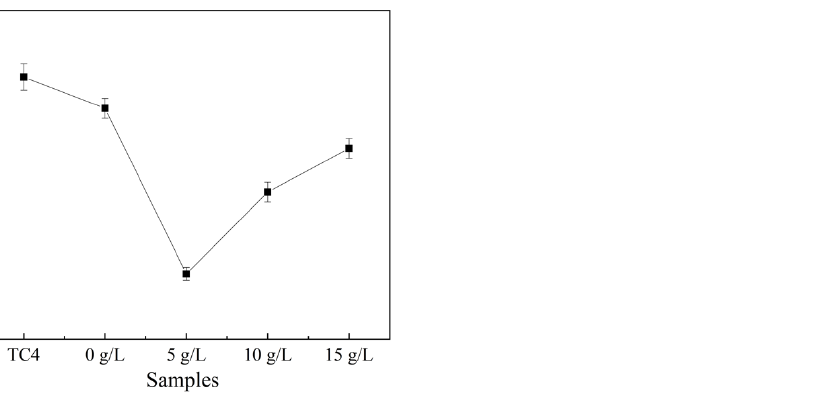
Figure 8. Optical density of S. aureus cultured by TC4 and MAO-Cu/Cu-(HEA)N composite coatings with different CuSO 4 concentrations.